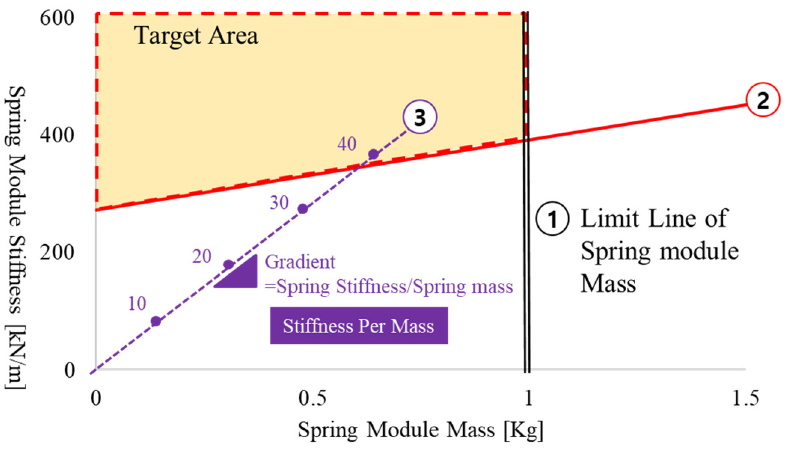
Figure 5. Design target area of spring module.